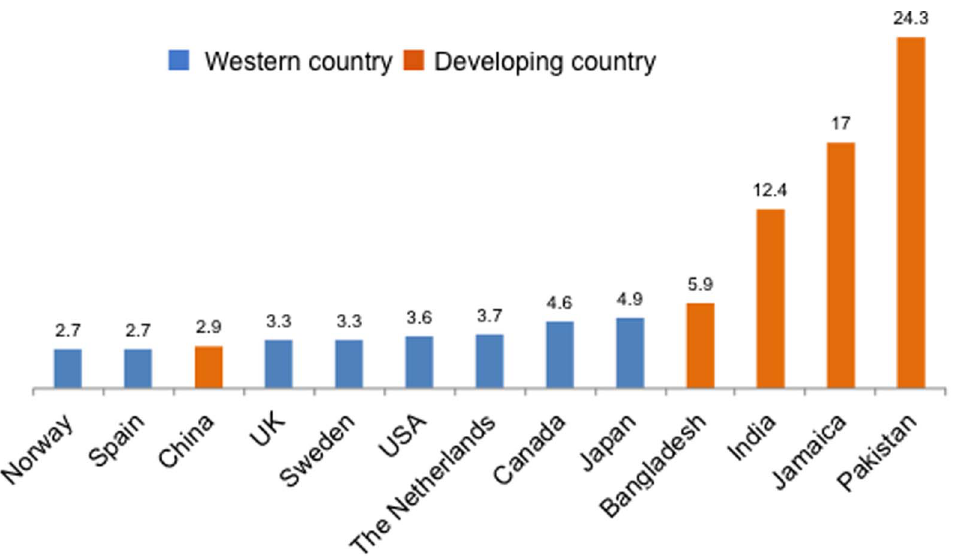
Figure 1. Distribution of the prevalence of severe neurodevelopmental impairment per 1,000 children in select countries. Taken from Durkin, The Epidemiology of Developmental Disabilities in Low- Income Countries, Mental Retardation and Developmental Disabilities Research Reviews p. 207 (2002)